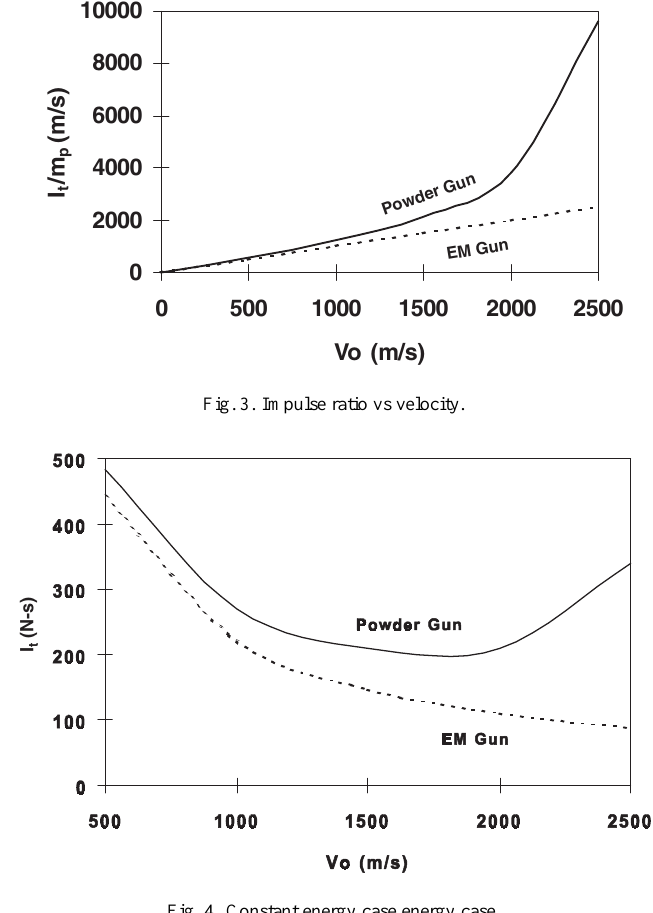
Fig. 4. Constant energy case energy case.